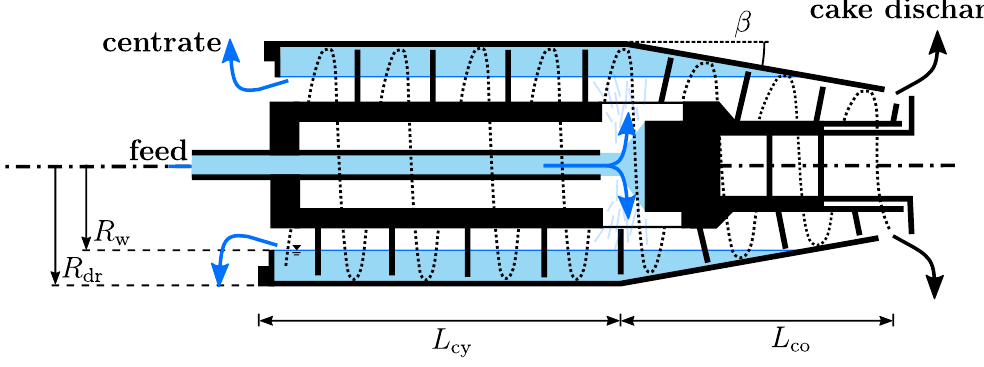
Figure 1. Principle scheme of a counter-current decanter centrifuge with geometrical